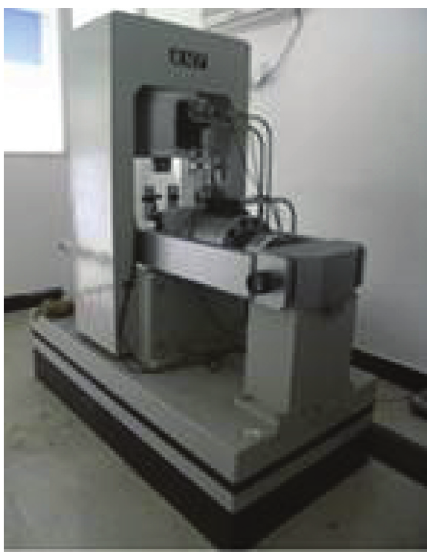
Figure 2: RMT-150C rock mechanics test system.